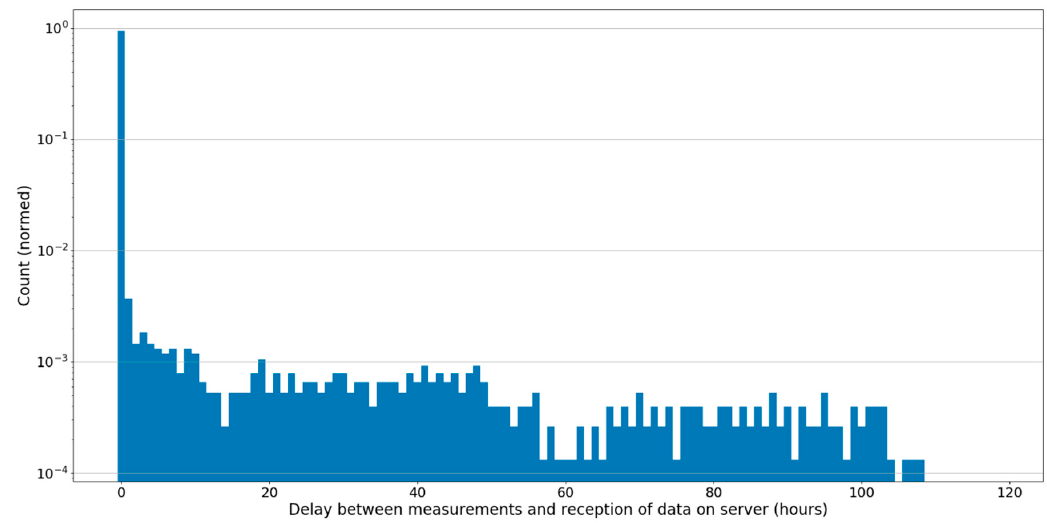
Figure 8. Logarithmic distribution of the delay between measurement and registration in the server